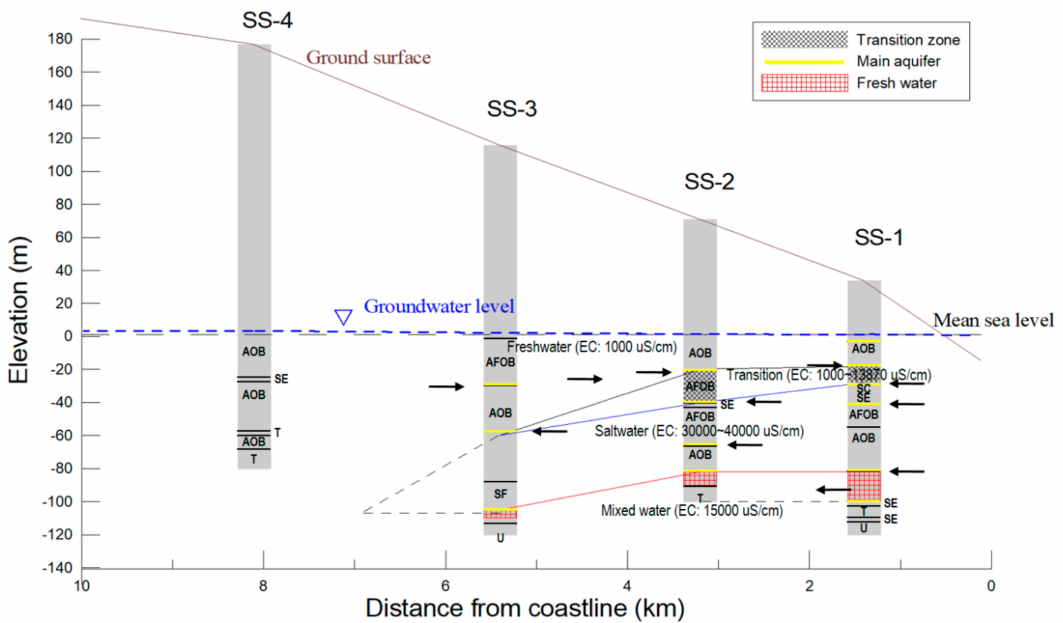
Figure 8. Conceptual model of heterogeneous coastal aquifer system proposed from the data interpretation of geophysical well logging and borehole temperature monitoring. Solid black and blue lines indicate the bottom of the freshwater body and transition zone, respectively. Solid red line represents the decrease of electrical conductivity. Arrows denote the coastal aquifer groundwater flow during